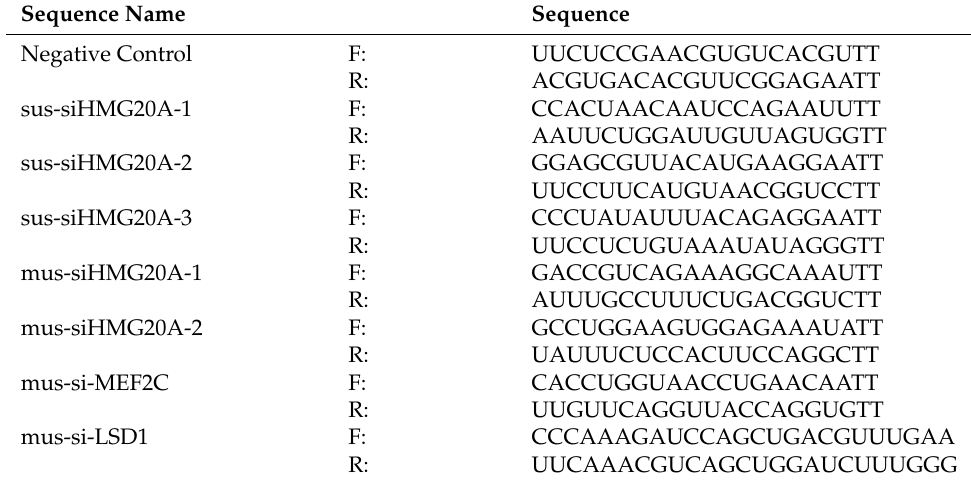
Table 1. The sequence of